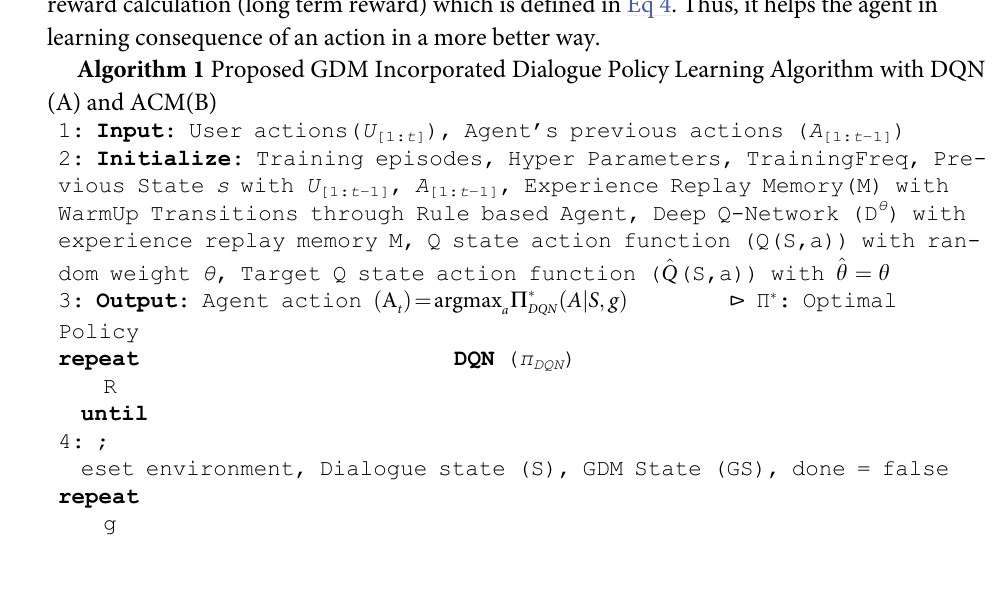
Algorithm 1 Proposed GDM Incorporated Dialogue Policy Learning Algorithm with